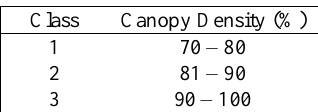
Table 2. The canopy density classification over study area